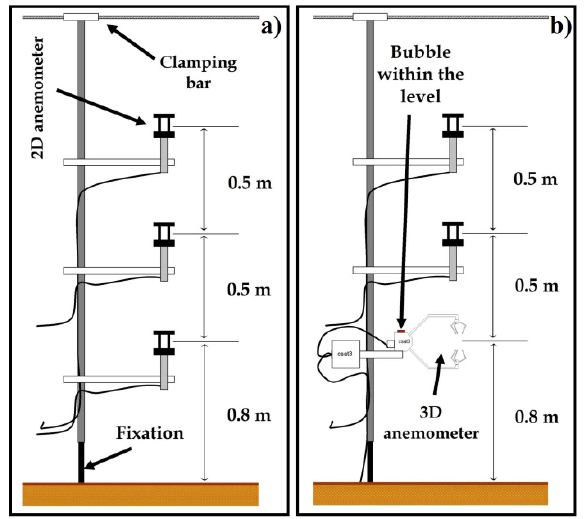
Figure 4. Details of the experimental setup using three 2D ultrasonic anemometers ( a ) and ( b ) one 3D and two 2D ultrasonic